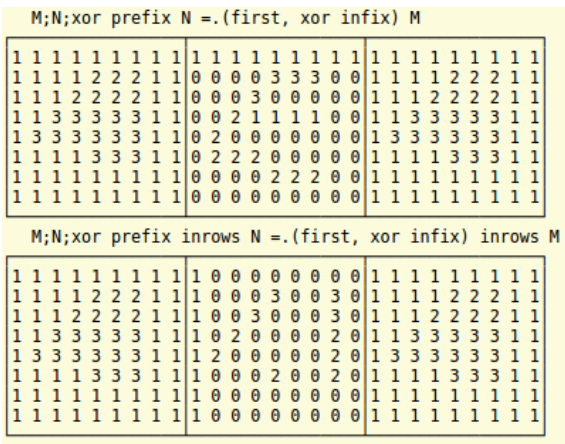
Fig 6. Illustration of xor infix converting a full area grid (left) to a sparse boundary grid (centre), either by columns (top) or by row (bottom). The corresponding xor prefix converts in the other